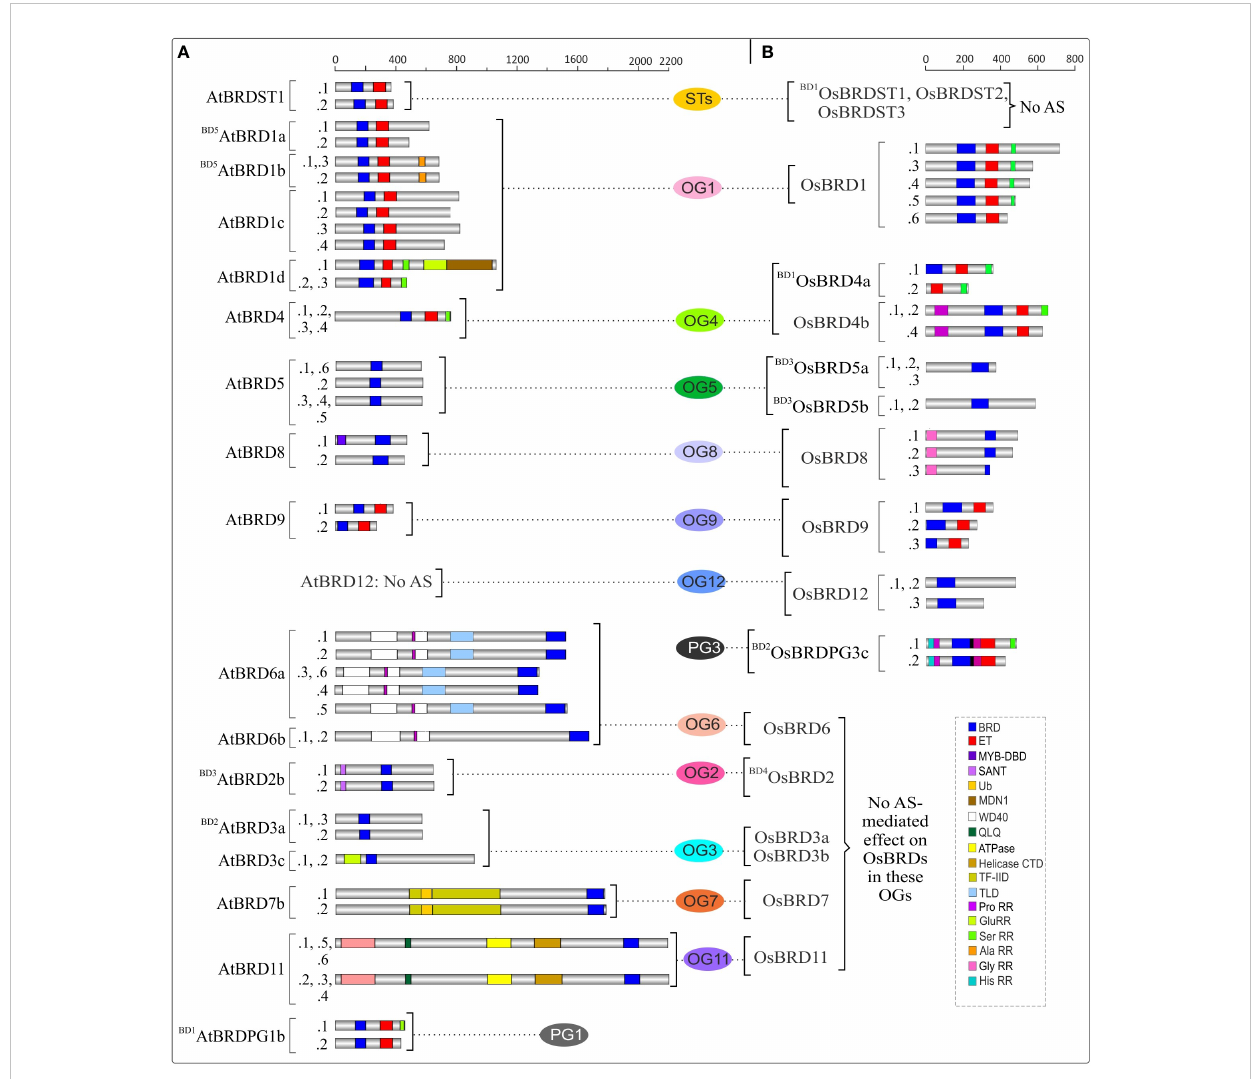
FIGURE 4 Alternative splicing (AS)-mediated changes in domain architecture of BRD isoforms of A. thaliana (A) and O. sativa (B) belonging to certain ortholog groups (OGs), paralog groups (PGs), and singleton category (STs). The members speci fi c to each group are arranged side-by-side for comparison, and the designations ‘ BD ’ and ‘ TD ’ in the names indicate the block or tandem duplication. Domains/important functional sites among different isoforms (constitutive:.1 and alternative: .2 to .6) are shown by different color codes. Scale on the top indicates the protein length (number of amino